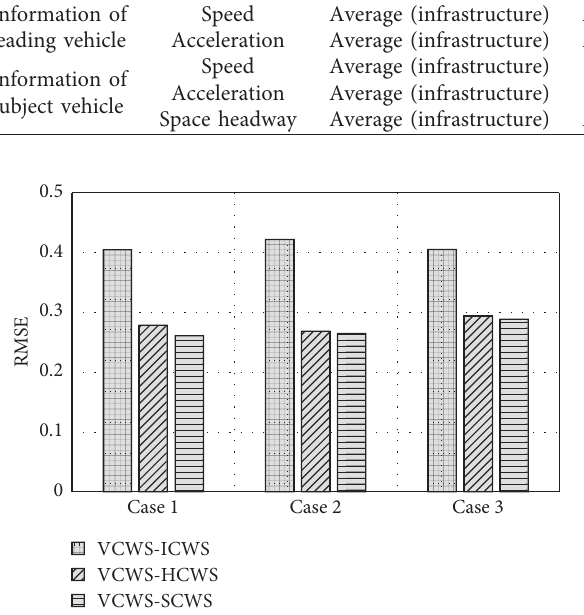
Figure 4: RMSE between the VCWS and the ICWS, HCWS, and SCWS for three